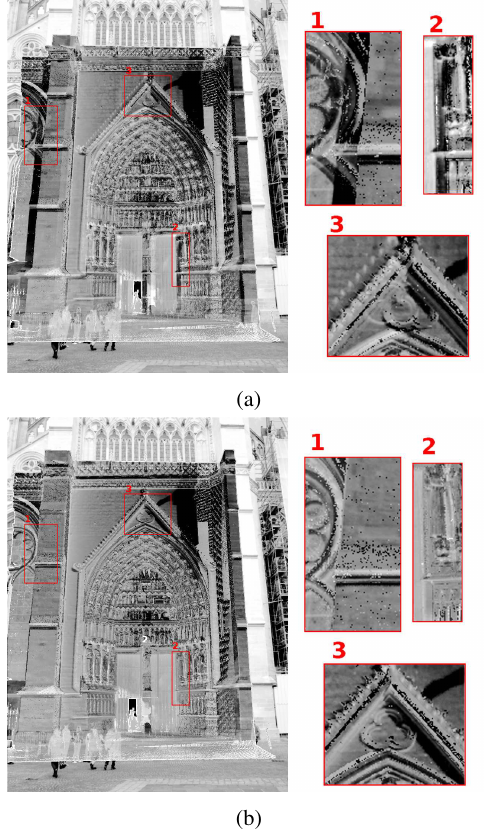
Figure 8: Differences images between the desired digital image and (a) the intial image (b) the final image view choice. To improve the detail visibilities we need a better image resolution for the colorization. Therefore, we have to take images from nearest positions from the statue.